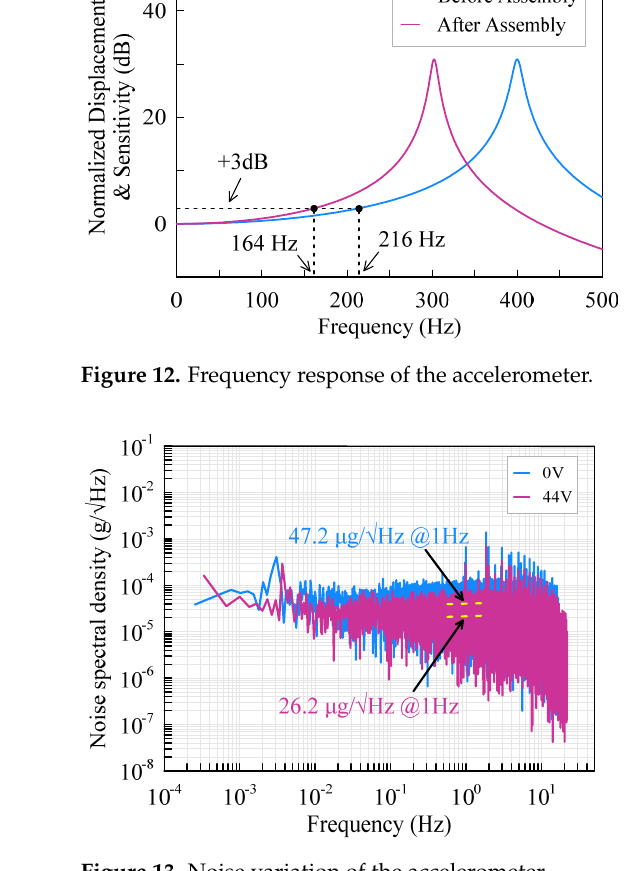
Figure 13. Noise variation of the accelerometer.